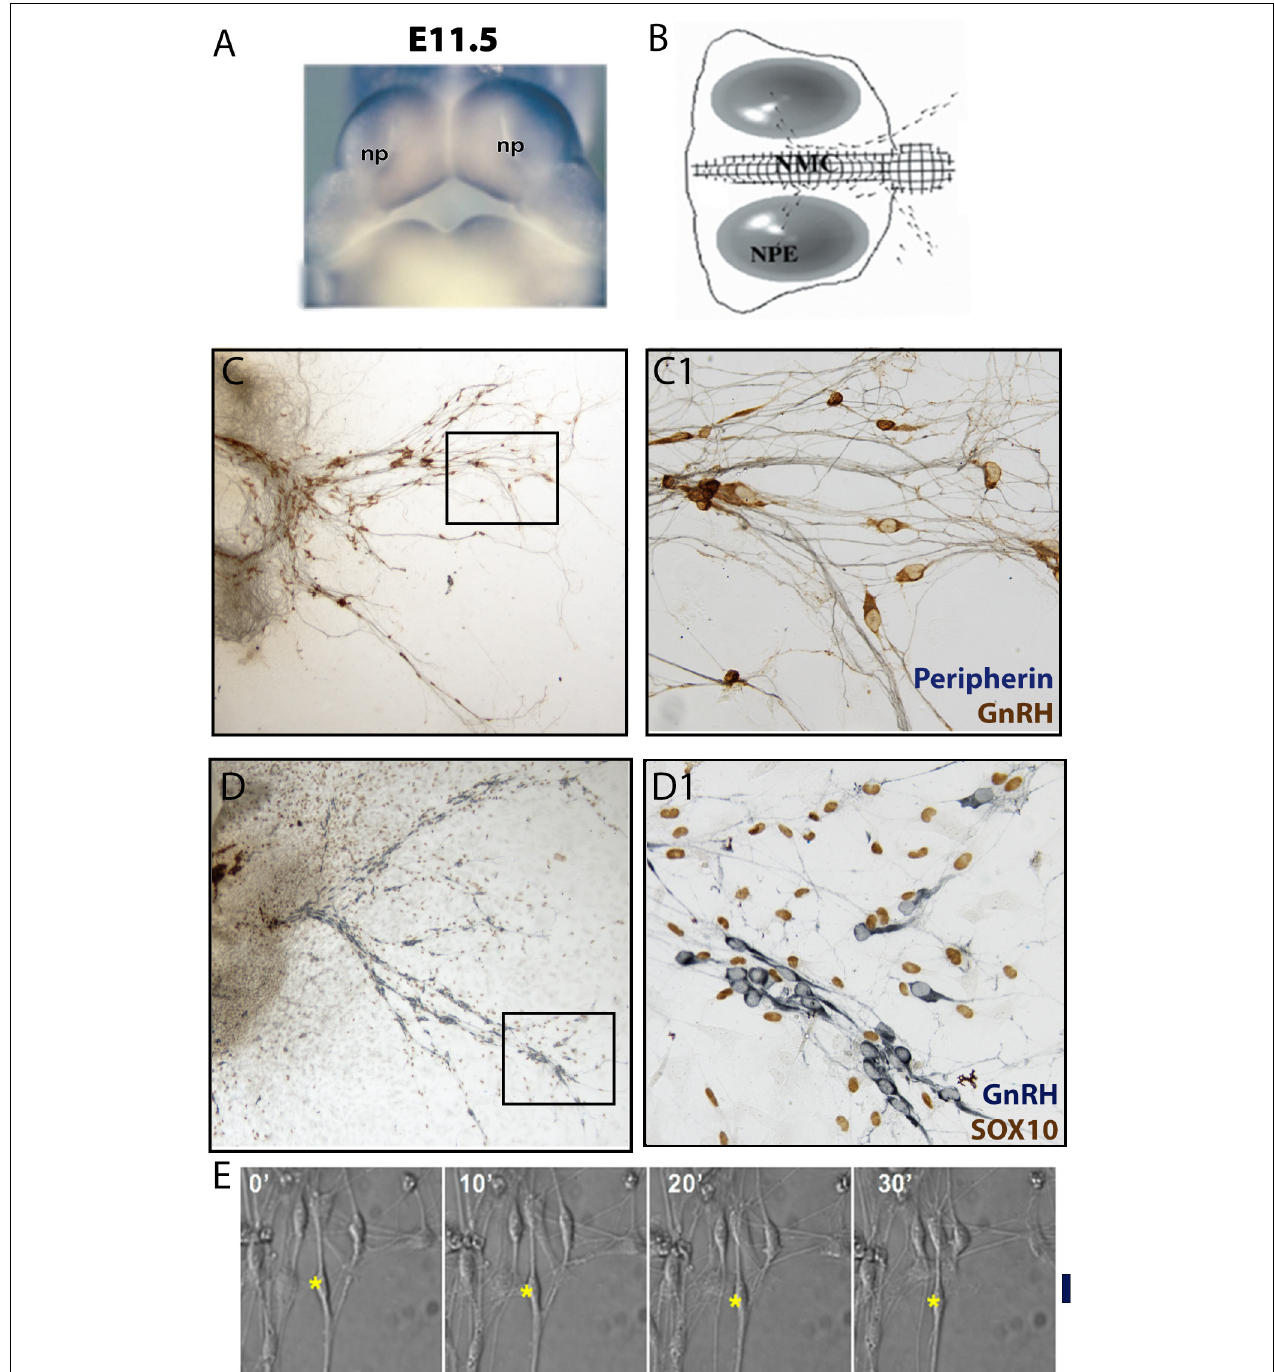
FIGURE 3 | Nasal explant model and migration assay. (A) Picture of E11.5 mouse embryo showing the location of the nasal pits (NP). (B) Schematic of a nasal explant after 4 days in vitro (div); nasal midline cartilage (NMC) and olfactory/VNO epithelium (NPE). GnRH neurons (black dots) migrate out of the nasal pit, toward the NMC, and then into the explant periphery. (C) 4div explant stained for peripherin (blue, marking olfactory axons) and GnRH (brown) (D) 4div explant stained for GnRH (blue) and SOX10 (brown, marking olfactory ensheathing cells nuclei). Boxed areas are magnified in panels (C1,D1) , respectively. (E) Example of migration assay using a 4div nasal explant. GnRH cell movement is recorded within a 30 min time frame. ∗ , nucleus location of GnRH neuron; Black line, linear distance moved after 30 min.